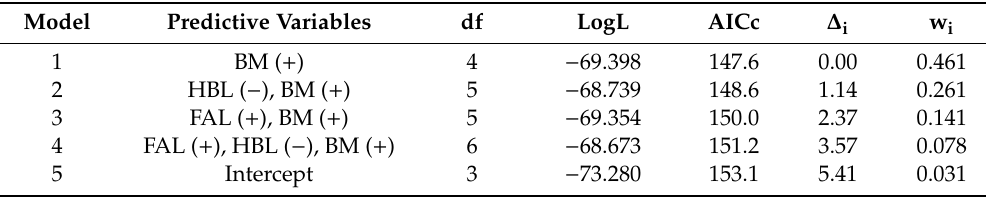
Table 2. Candidate linear mixed models explaining the variation in activity of female Asian particolored bats based on body size and date of capture as a random factor. The initial full model was of the form activity ~BM + FAL + HBL + (1 | Month).